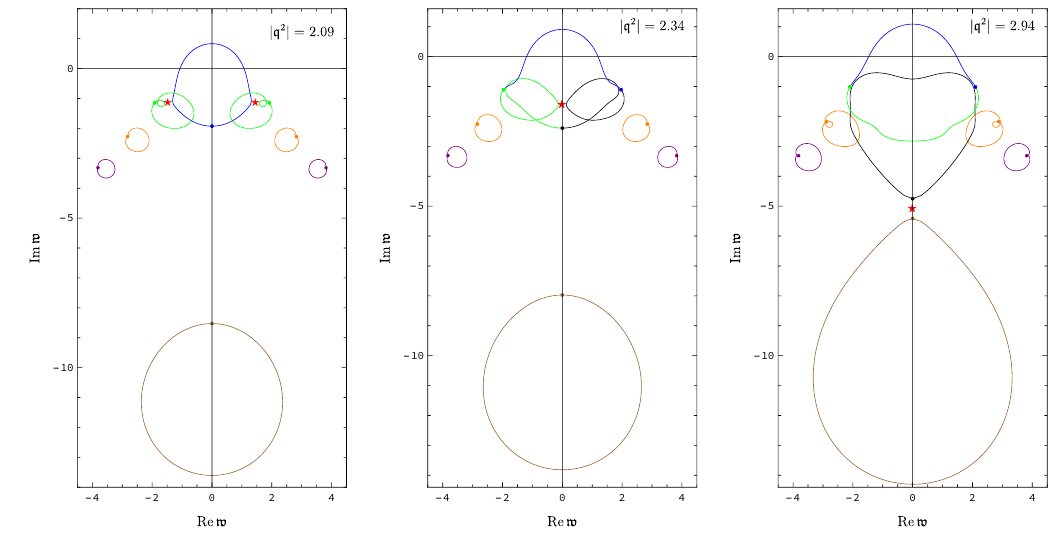
Figure 11 . Quasinormal spectrum in the shear channel of Gauss-Bonnet theory, computed non- perturbatively in λ , at λ = − 0 . 01 . The trajectories are plotted for complex values of the GB GB spatial momentum squared, q 2 = | q 2 | e iϕ , where phase ϕ is varied from 0 to 2 π . The positions of quasinormal modes at ϕ = 0 are shown by dots. The positions of the critical points are shown by red